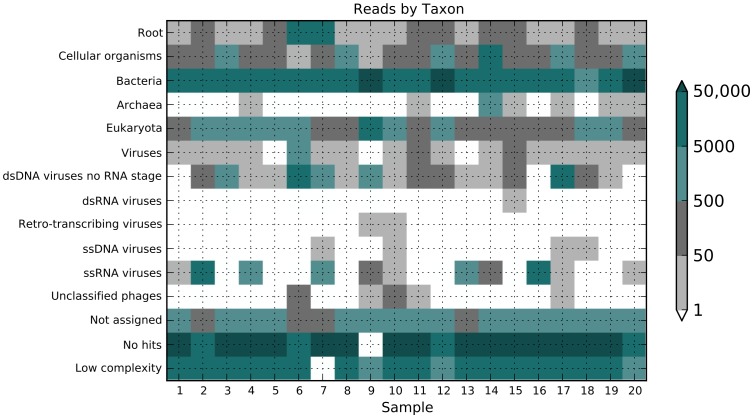
Taxonomy of reads in each sample.100,000 random reads from each sample dataset were subject to a nucleotide BLASTN search and hits with e values less than 0.001 were collected, and processed with MEGAN4 (see Materials and Methods). The Megan output was processed using Python script to generate a heat map of total reads in each sample in each category. Values were grouped into 5 categories and depicted with the following colors: less than 0 reads, white; 1–50 reads, grey; 51–500 reads, dark grey; 501 to 5000 reads, light green; 5001 to 50,000 reads, green, >50,000 reads, dark green (also see color bar scale to right of figure).